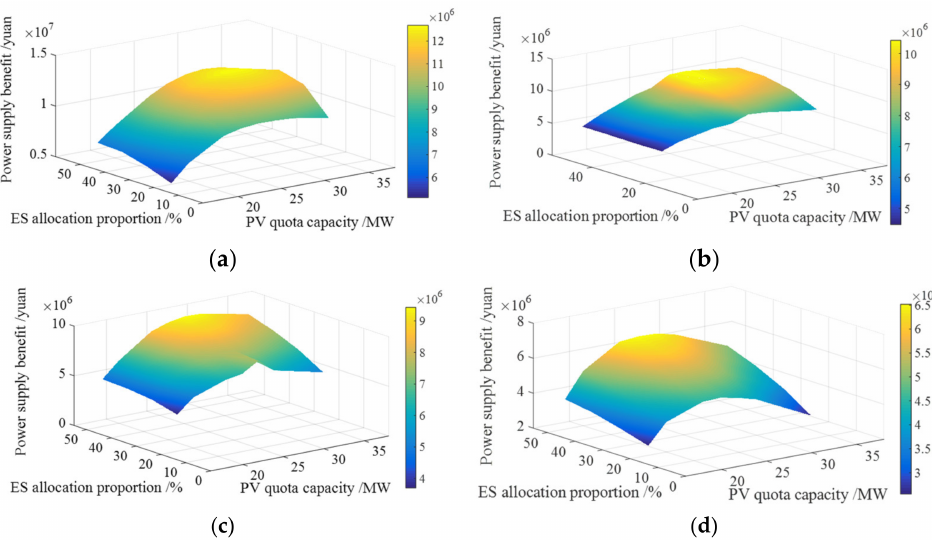
Figure 9. Power supply benefit when discharge duration of ES is 4 h, 3 h, 2 h, and 1 h: ( a ) benefit when discharge duration is 4 h; ( b ) benefit when discharge duration is 3 h; ( c ) benefit when discharge duration is 2 h; ( d ) benefit when discharge duration is 1